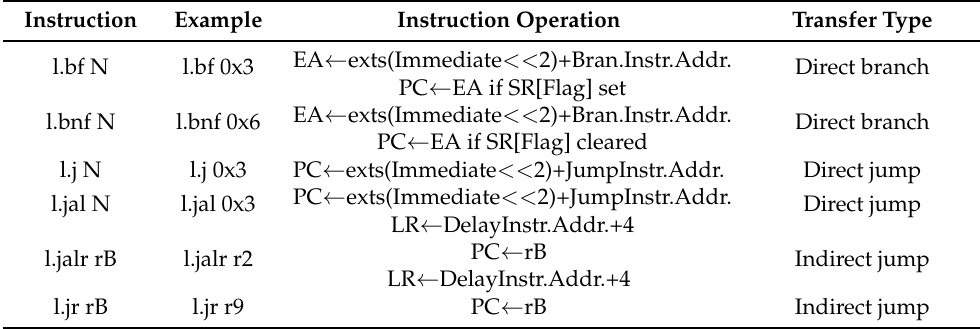
Table 1. The transfer type instructions in the OpenRISC instruction set architecture (ISA).